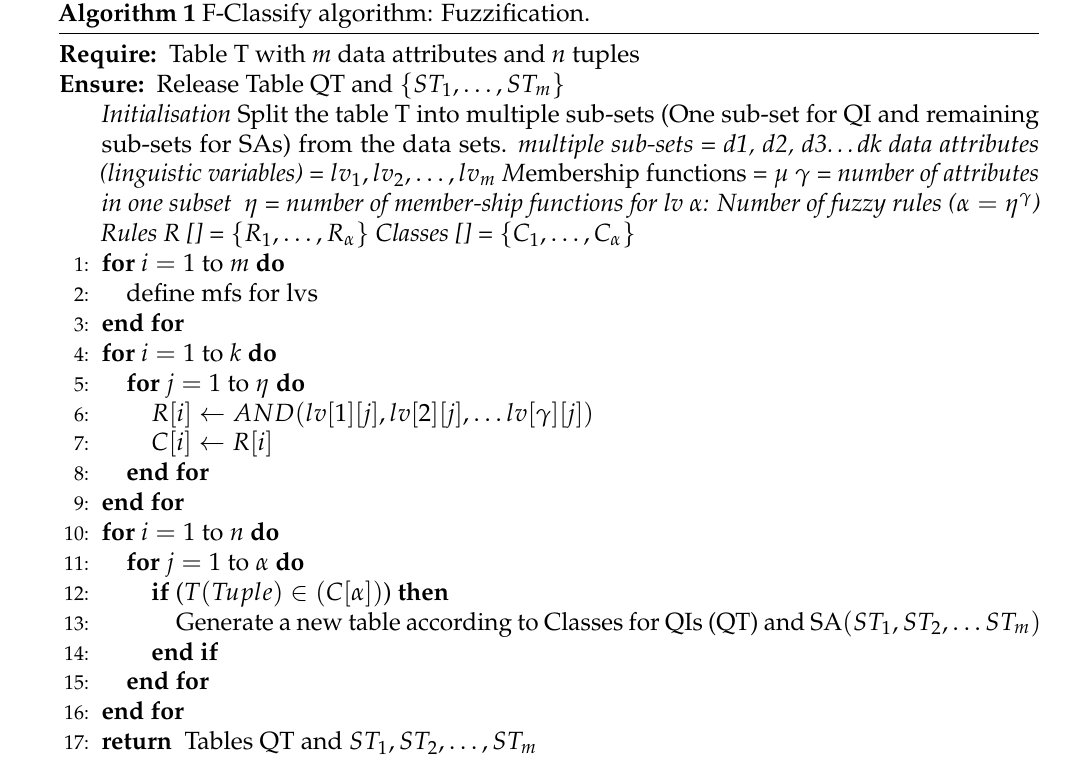
Algorithm 1 F-Classify algorithm: